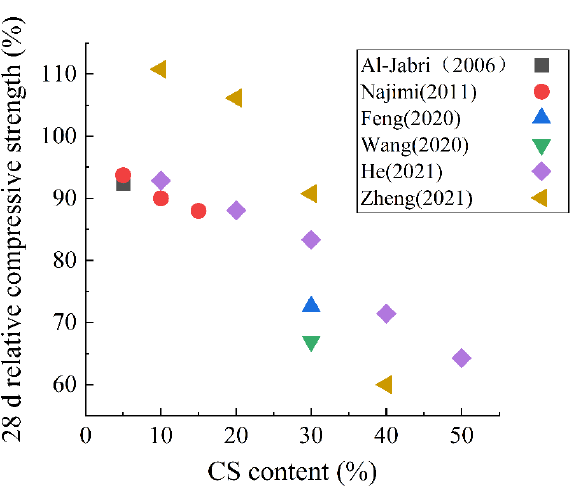
Figure 8. The 28 d relative compressive strength of hardened paste with CS as an SCM [16,27,29,110–